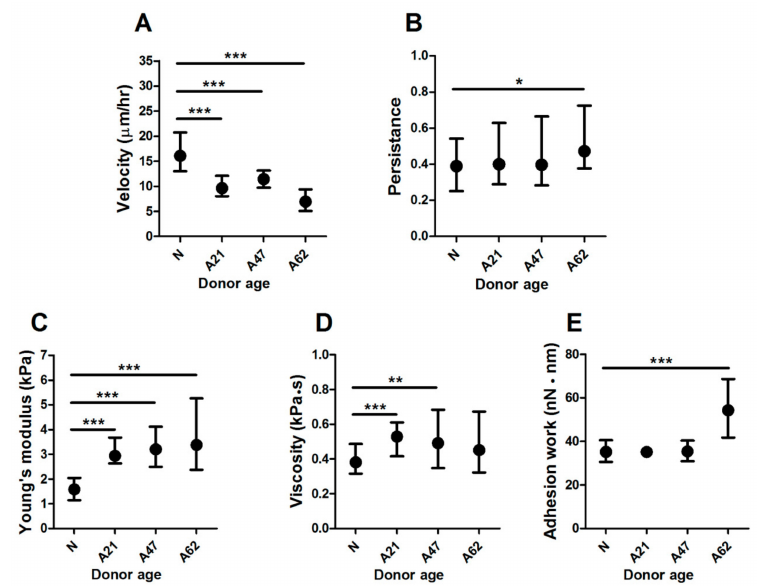
Figure 1. Biophysical properties are altered by donor age. ( A ) Corresponding plot showing reduced cell velocity of single fibroblasts on two-dimensional substrates in relation to donor age. Cell persistence was significantly different only for cells from oldest donor ( B ). Data plotted from at least three independent experiments as geometric mean with quartiles, cell number varies between (50–60). Cells from aged donors exhibitedincreasedviscoelasticpropertiescomparedtocellsfromneonataldonorsasquantifiedbysignificant differences in ( C ) Young’s modulus, ( D ) viscosity, and ( E ) adhesion work estimated using AFM measurement. All data plotted from at least three independent experiments as geometric mean with quartiles, ** p < 0.01, *** p < 0.001, Mann–Whitney U test. Cell number varies between 30–90 with ~12 cells per